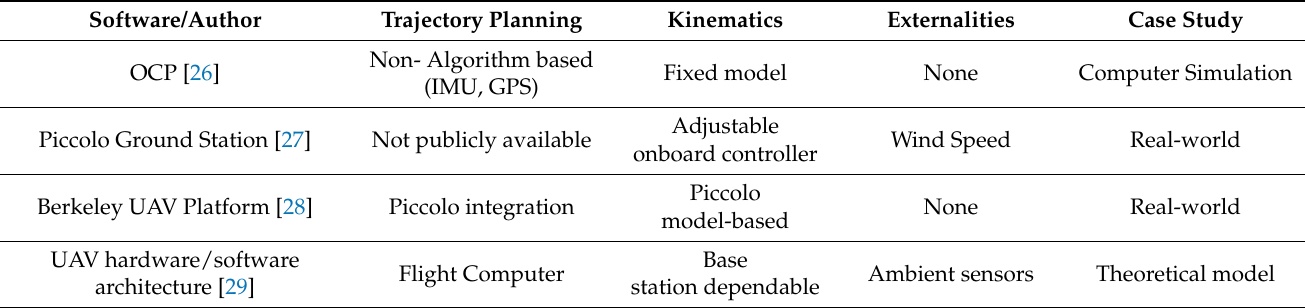
Table 1. UAV integrated simulation platforms available in the